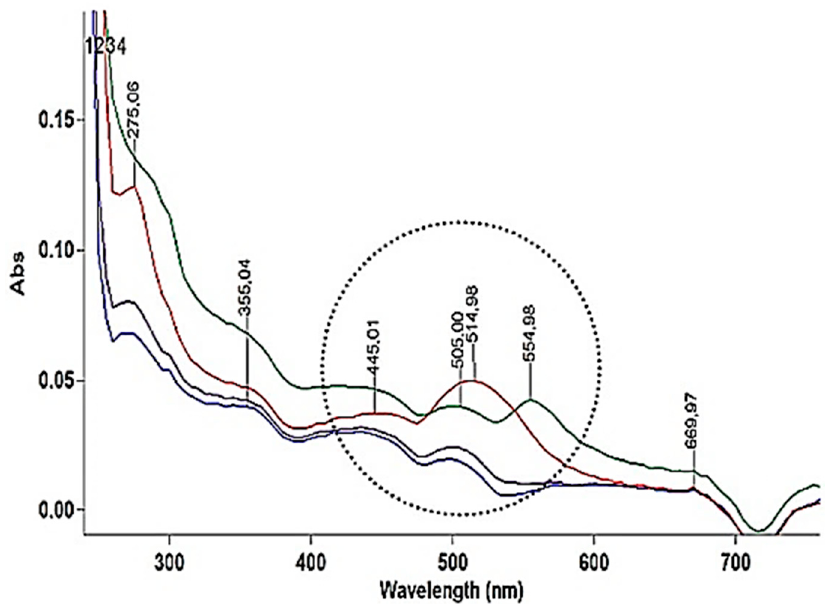
Figure 8. UV-Vis absorption spectrum of cotton wefts: 1-Sample 6 (Fragment 1), 2-Sample 8 (Fragment 2), 3-Sample 2 (Chasuble), 4-Sample 4 (Velum).